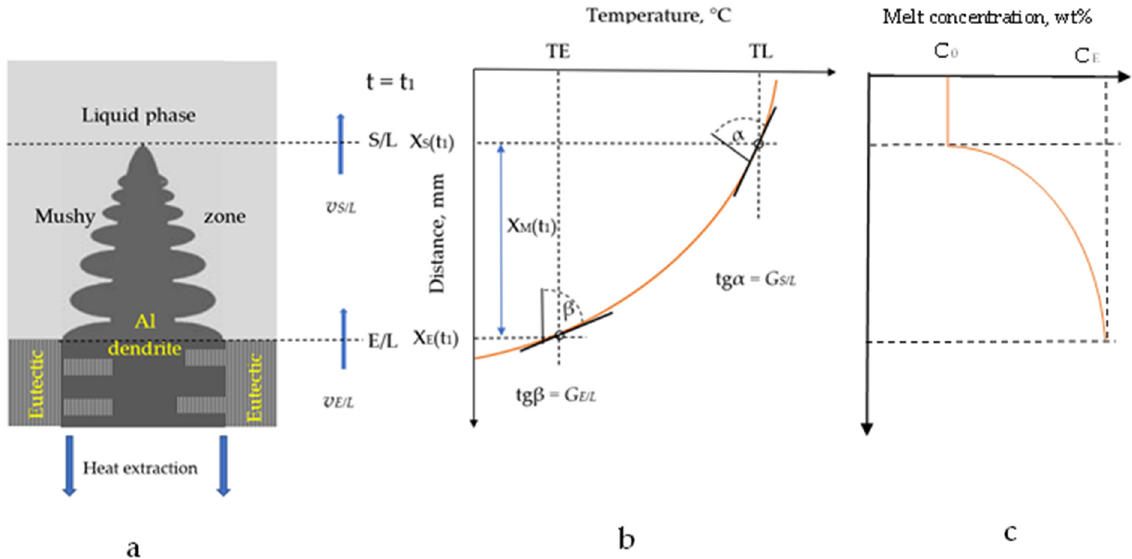
Figure 1. Sketch of the solidifies part of sample ( a ), temperature ( b ), and melt concentration ( c ) dis- tribution in the mushy zone, with the solidification fronts ( S / L , E / L ), fronts position ( X S ( t 1 ), X E ( t 1 )) and lengths of the mushy zone ( X M ( t 1 ) vs. time), front velocities ( v S / L , v E / L ), temperature gradients at the fronts, ( G S / L , G E / L ) in an arbitrary t 1 time.